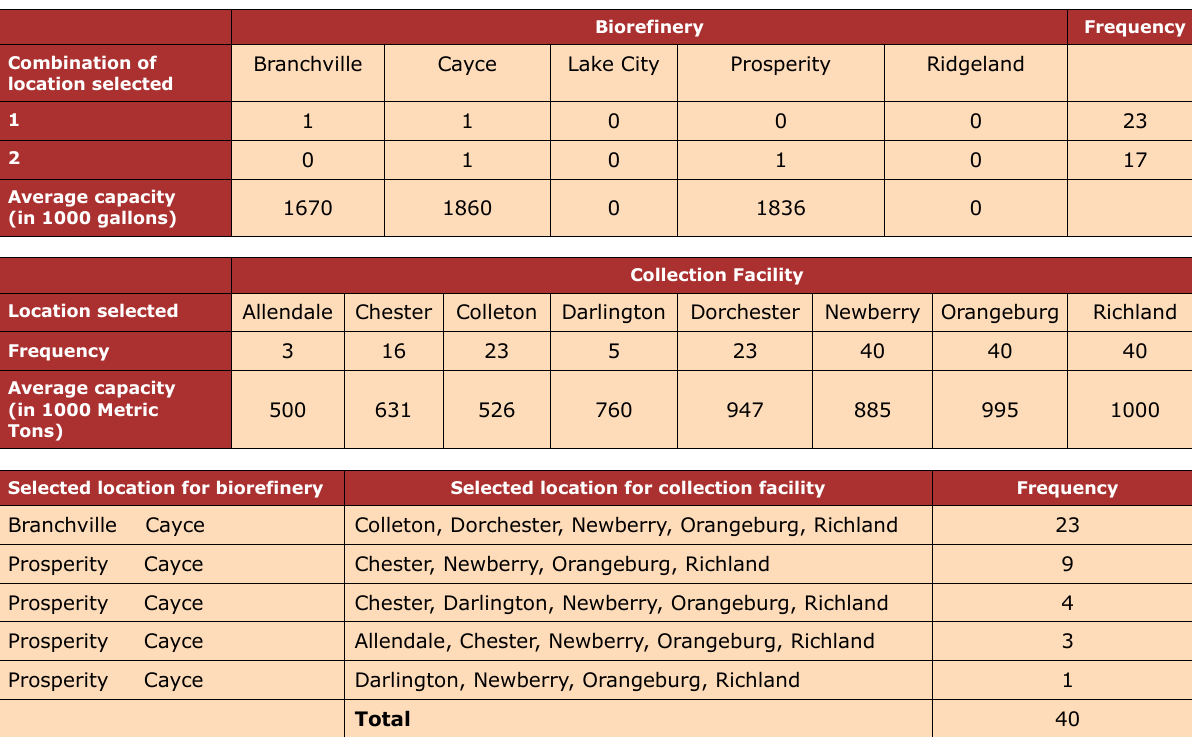
Table 2a. Simulation Results of Locations of Biorefinery and Collection Facility for Case 1 (Normal Distribution)